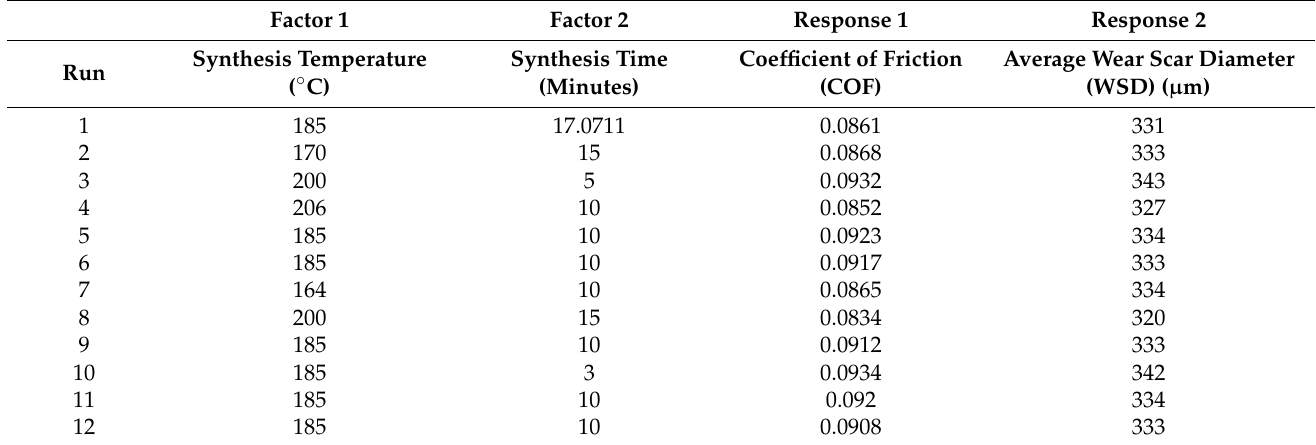
Table 3. The experimental design and results.